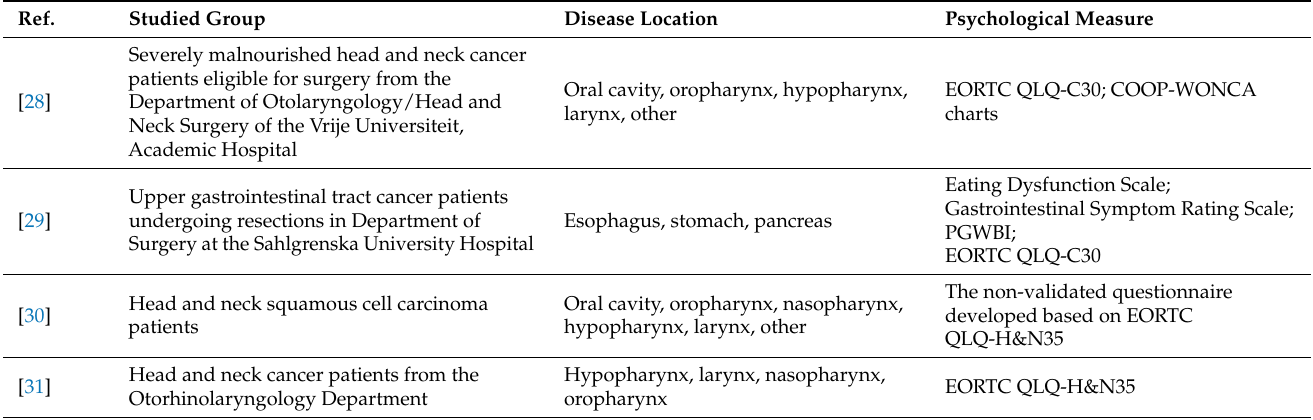
Table 4. The basic characteristics of the influence studied within the studies included in the systematic review.